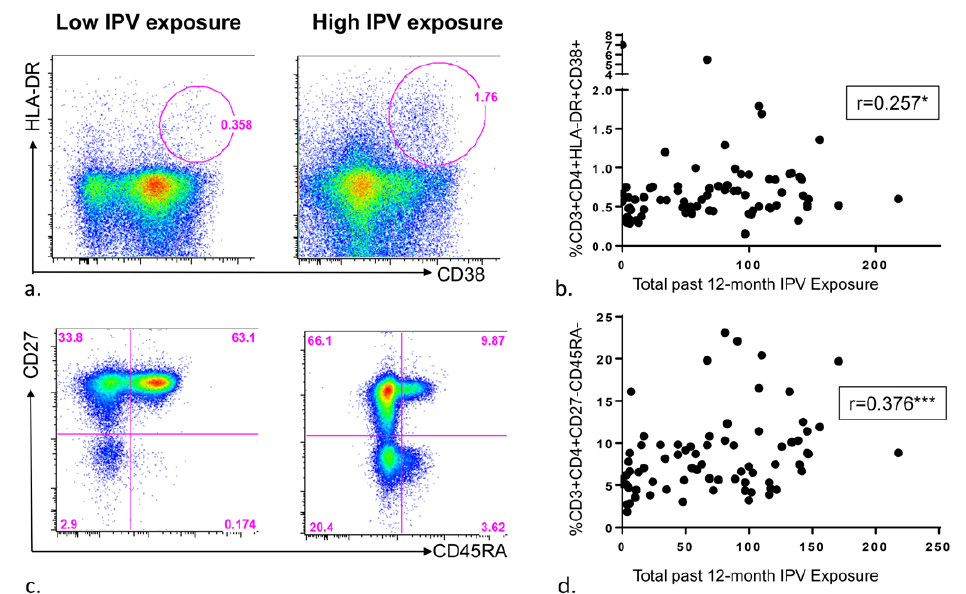
Figure 2. Association between past-year intimate partner violence (IPV) experience and CD4 + T-cell activation and memory phenotype among HIV high-risk women. (A) Representative flow diagrams demonstrating CD4 + T-cell activation (%HLA-DR + /CD38 + ) in the whole blood of two donors with low versus high reporting of past-year IPV experience. (B) Summary data from 75 HIV high-risk women demonstrating past-year IPV reporting is significantly associated with CD4 + T-cell activation (%HLA- DR + /CD38 + ) in whole blood. (C) Representative flow diagrams depicting frequencies of CD4 + T-cell mem- ory phenotypes using CD27 and CD45RA markers in the whole blood of two donors with low versus high reporting of past-year IPV experience, and (D) Summary data from 75 HIV high-risk women demonstrat- ing past-year IPV reporting is significantly associated with an increase in CD4 + effector memory T-cell population (%CD27 - CD45RA -